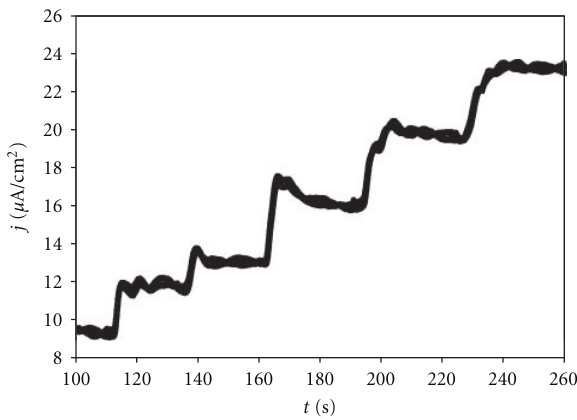
Figure 7: A typical amperometric response of the PANI-gold nanorod-enzyme biosensor after successive additions of 50 µ M concentrations of glucose at +0.6V versus Ag/AgCl in stirred Phosphate bu ff ered saline (PBS) of pH 6.4. (Glucose concentrations were prepared for the final concentrations to be 50, 100, 150, 200, and 250 µ